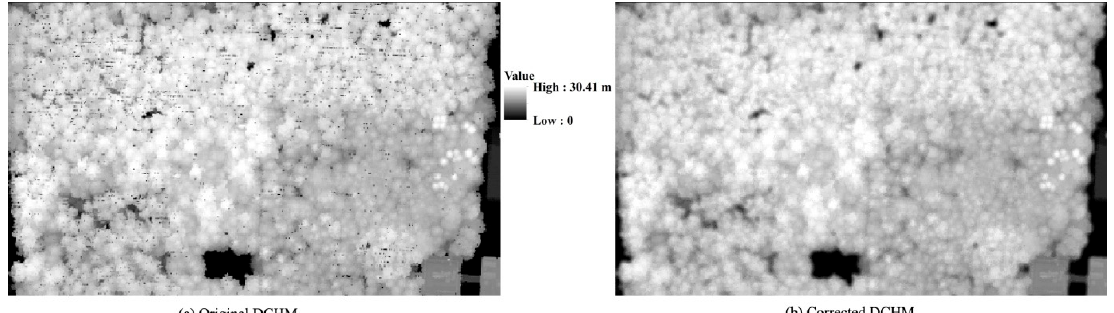
Figure 4. A part of the CHM data before and after correction.